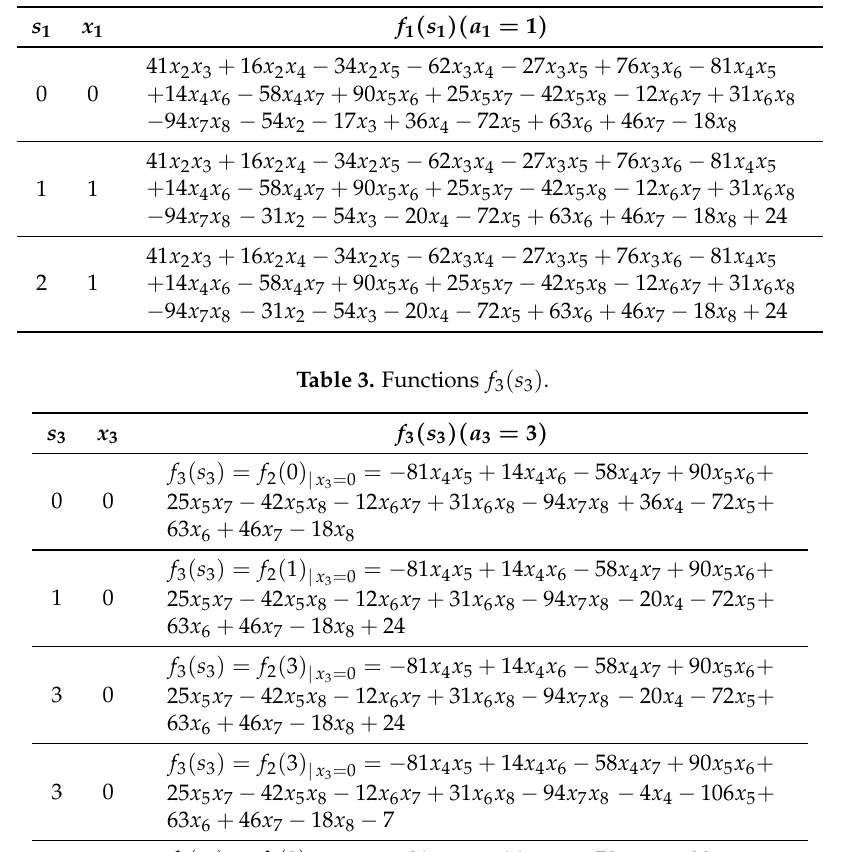
Table 2. Functions f 1 ( s 1 ) .